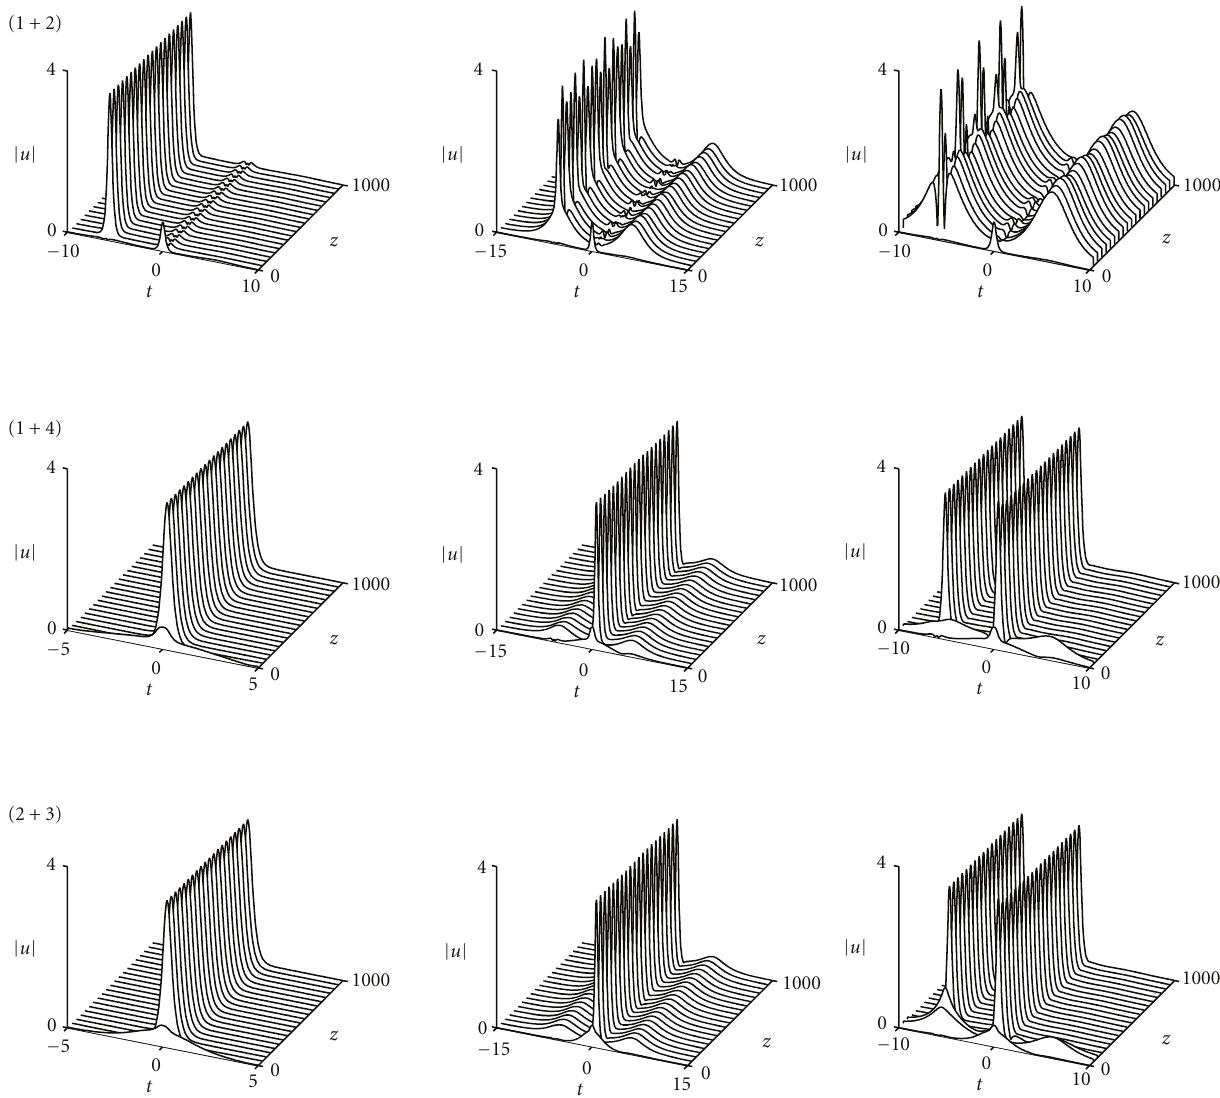
Figure 10: Top: the reconstructed field of the (1 + 2) model at g 0 = 3 (left), g 0 = 4 . 3 (middle), and g 0 = 7 (right). Middle: the reconstructed field of the (1 + 4) model at g 0 = 3 (left), g 0 = 3 . 4 (middle), and g 0 = 3 . 8 (right). Bottom: the reconstructed field of the (2 + 3) model at g 0 = 3 (left), g 0 = 3 . 4 (middle), and g 0 = 3 . 7